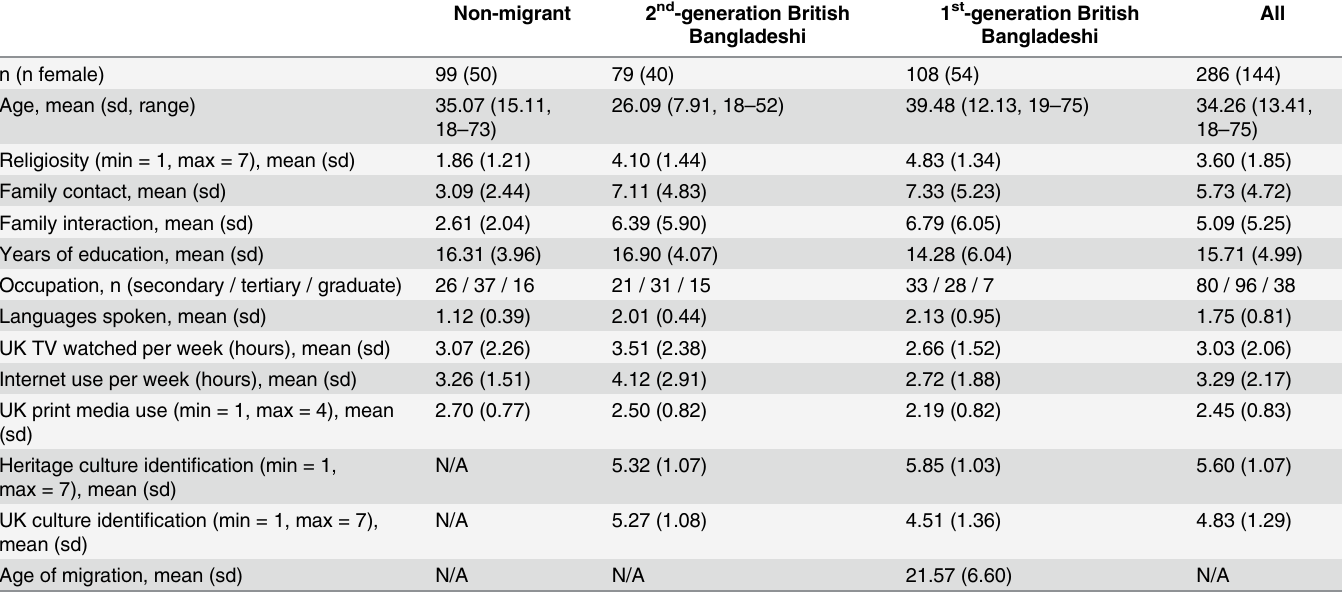
Table 1. Participant